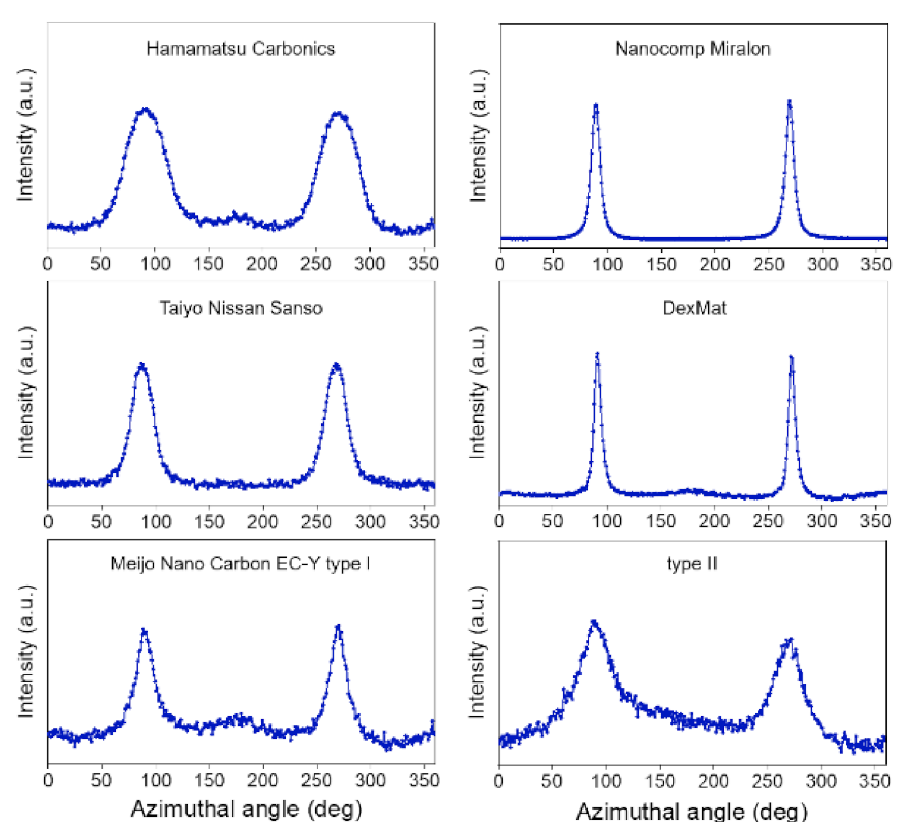
Figure 4. WAXD azimuthal scan of CNT yarns.